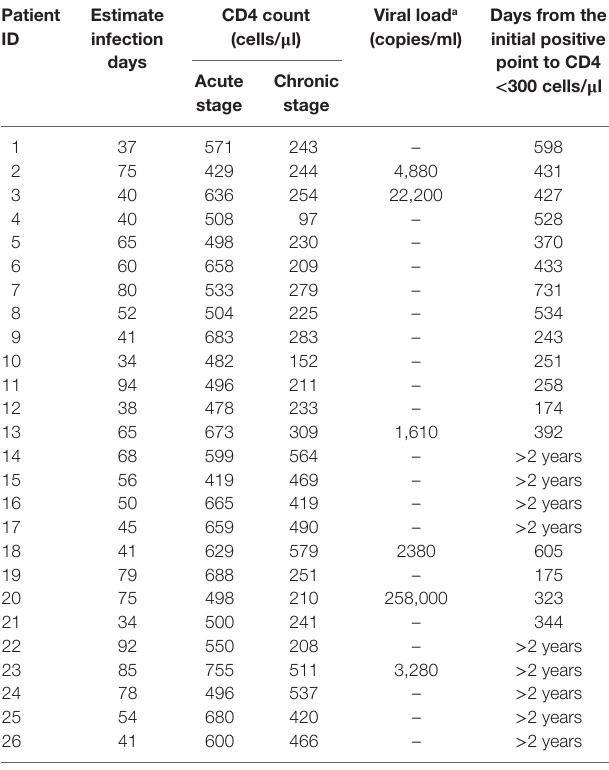
Table 1 | Patient characteristics. Patient